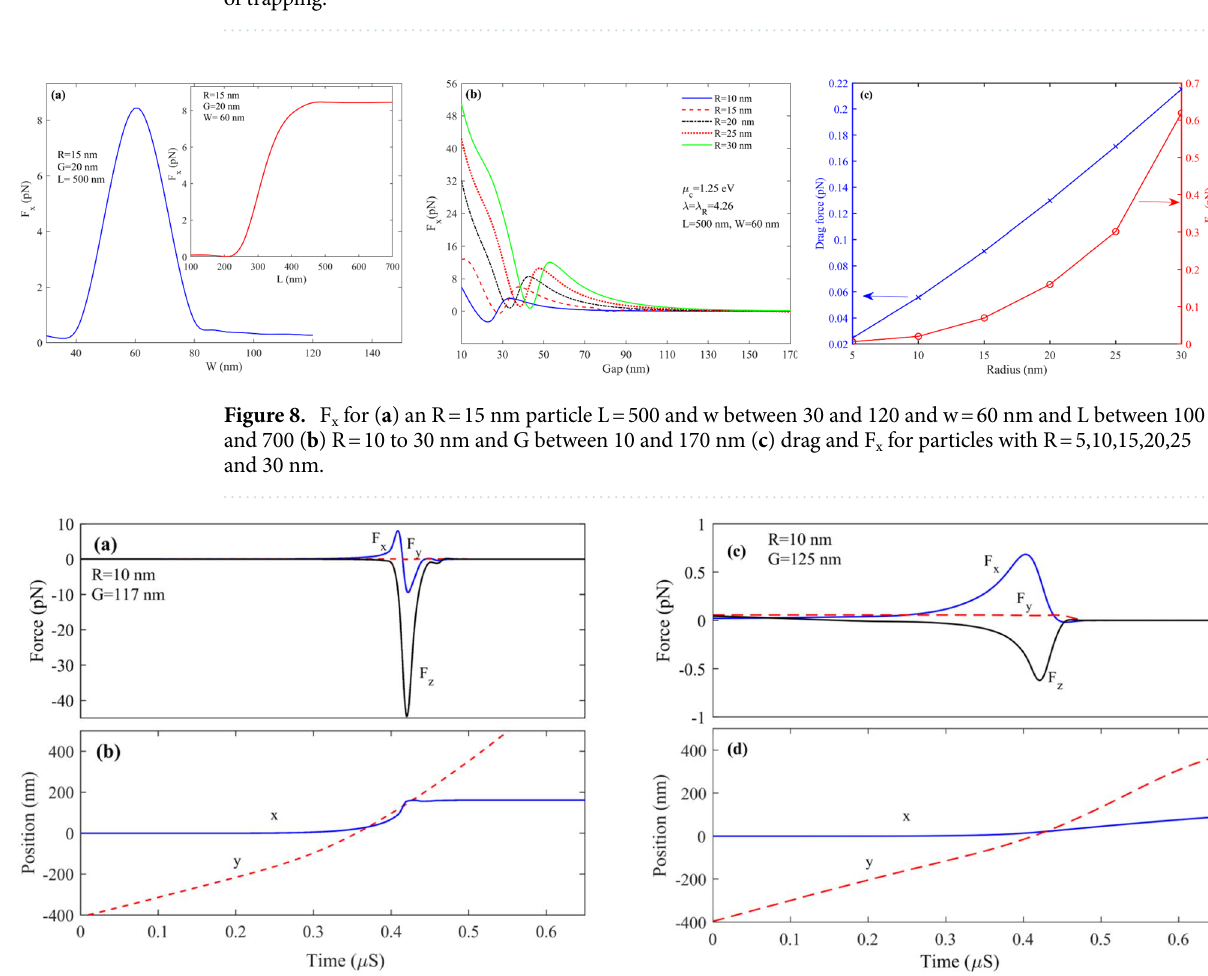
Figure 7. Forces felt by an R = 20 nm particle when ( a ) it is fixed at x = 0 and moves along the channel with G = 117 nm and ( b ) it is fixed at y = 0 and moves through the width of the channel with G = 117 and its potential of trapping.